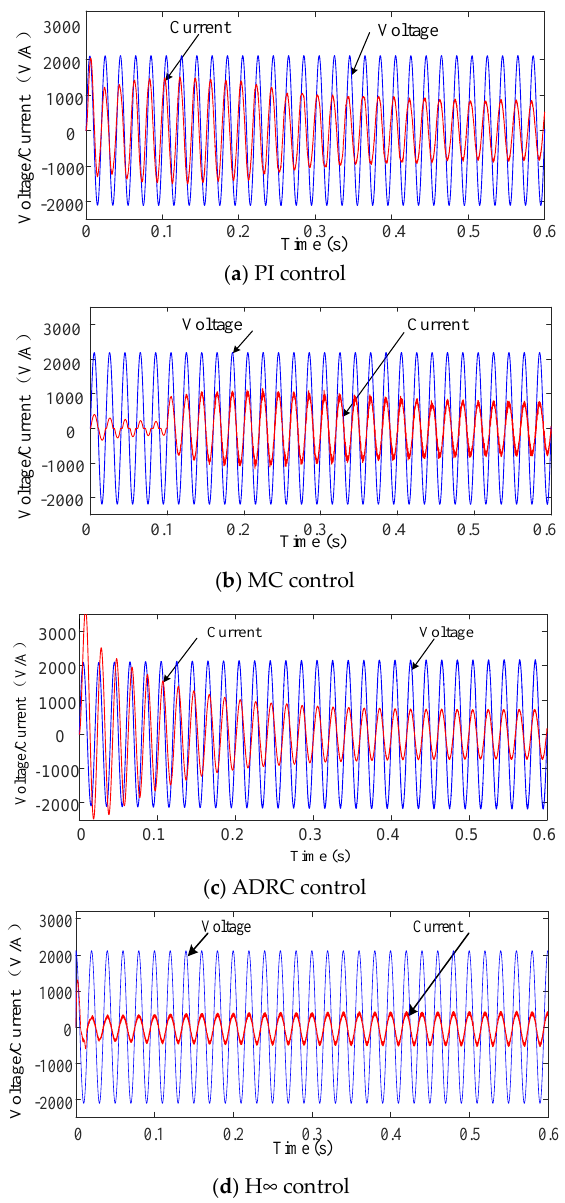
Figure 6. Simulation model of the twofold four-quadrant EMUs converter.